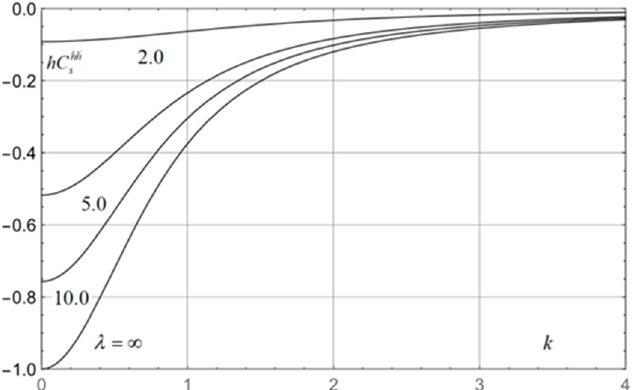
. .. . .. h h h h C C =   with respect = C C C =   with respect C C =   with respect s with respect t s t t s t s